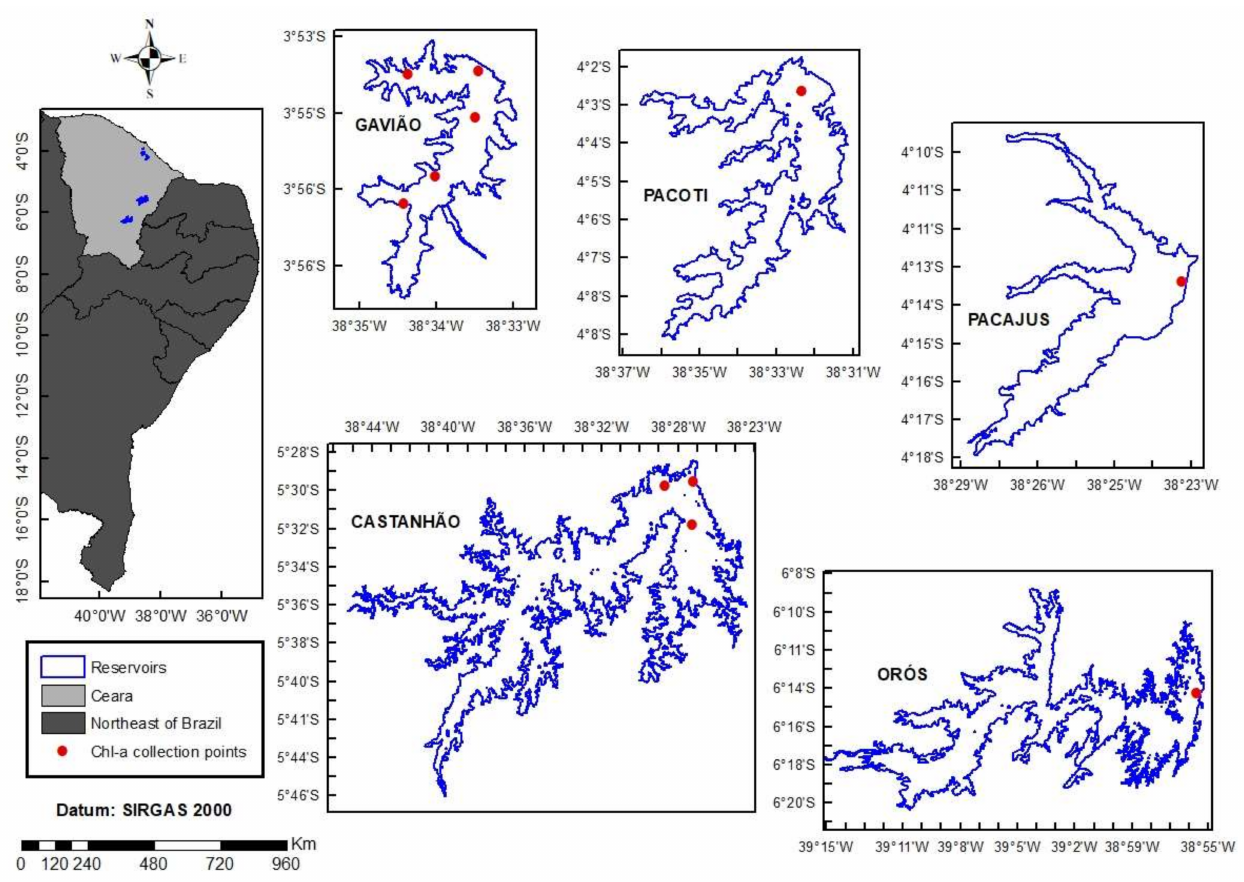
Figure 1. Location map of the five analyzed reservoirs and of the chlorophyll-a (chl-a) collection points collected and made available by Cear á Water Resources Management Company